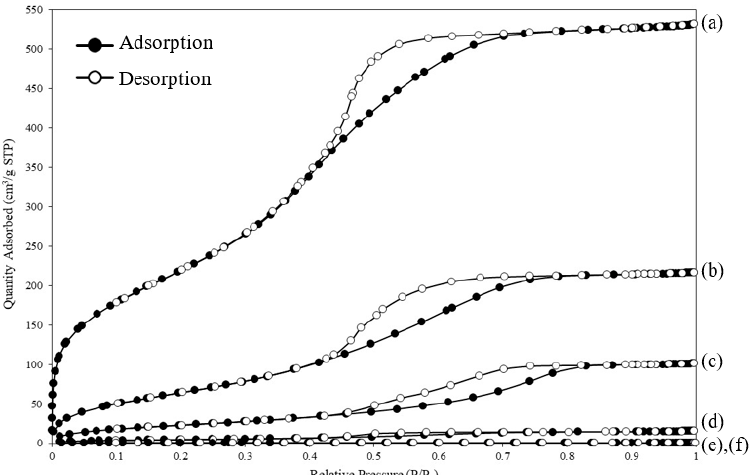
Figure 2. Nitrogen adsorption/desorption isotherms of ( a ) unfunctionalized MSU-2, and MSU-2 functionalized with TEPA loadings of ( b ) 20 wt%, ( c ) 30 wt%, ( d ) 40 wt%, ( e ) 50 wt%, and ( f ) 60 wt%. Table 1. Pore characteristics and elemental analysis of unfunctionalized and TEPA-functiona- lized